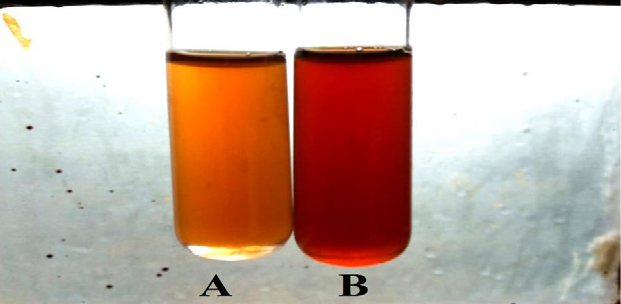
Fig. 6. Reaction mixture color change from light yellow (A) into intense brown color (after five minutes), which confirms biosynthesis of BL-AgNPs (B)